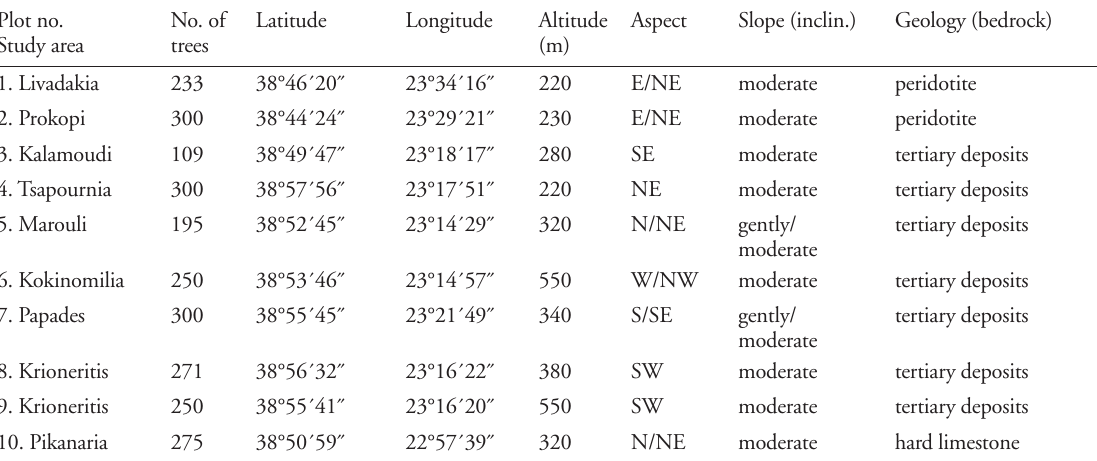
Table 1. Experimental plots (sites) selected for the study of resin production in northern Evia. Plot no. No. of Latitude Longitude Altitude Study area trees